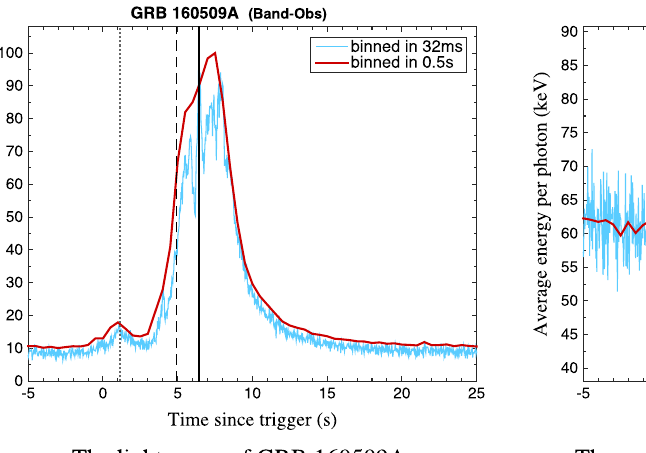
Fig. 11 The light curve and average energy curve of GRB 160509A in Band-Obs. The vertical solid lines refer to t obs /( 1 + z ) of Criterion 0 (the first main peak of the light curve) and the vertical dashed lines